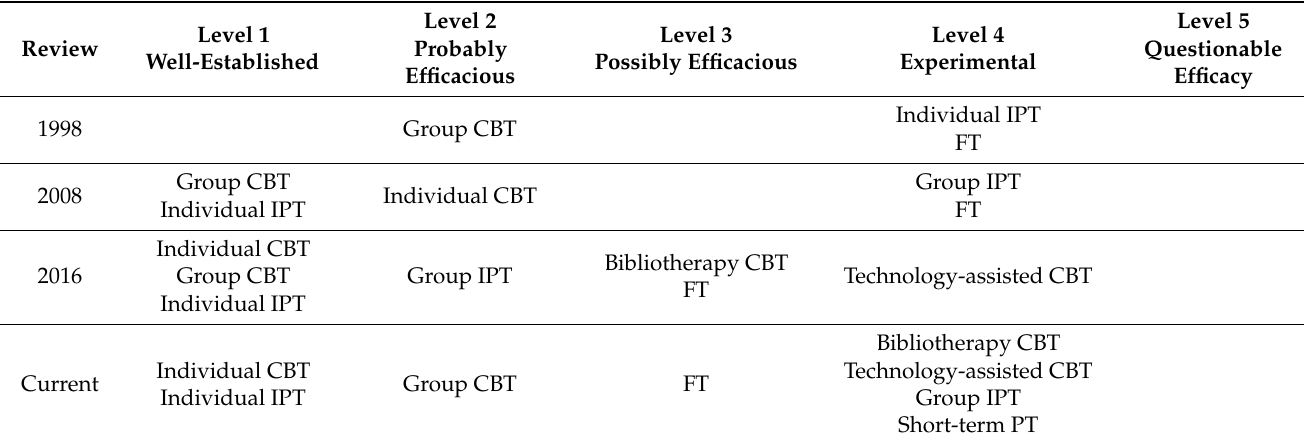
Table 5. Evidence base for adolescent depression